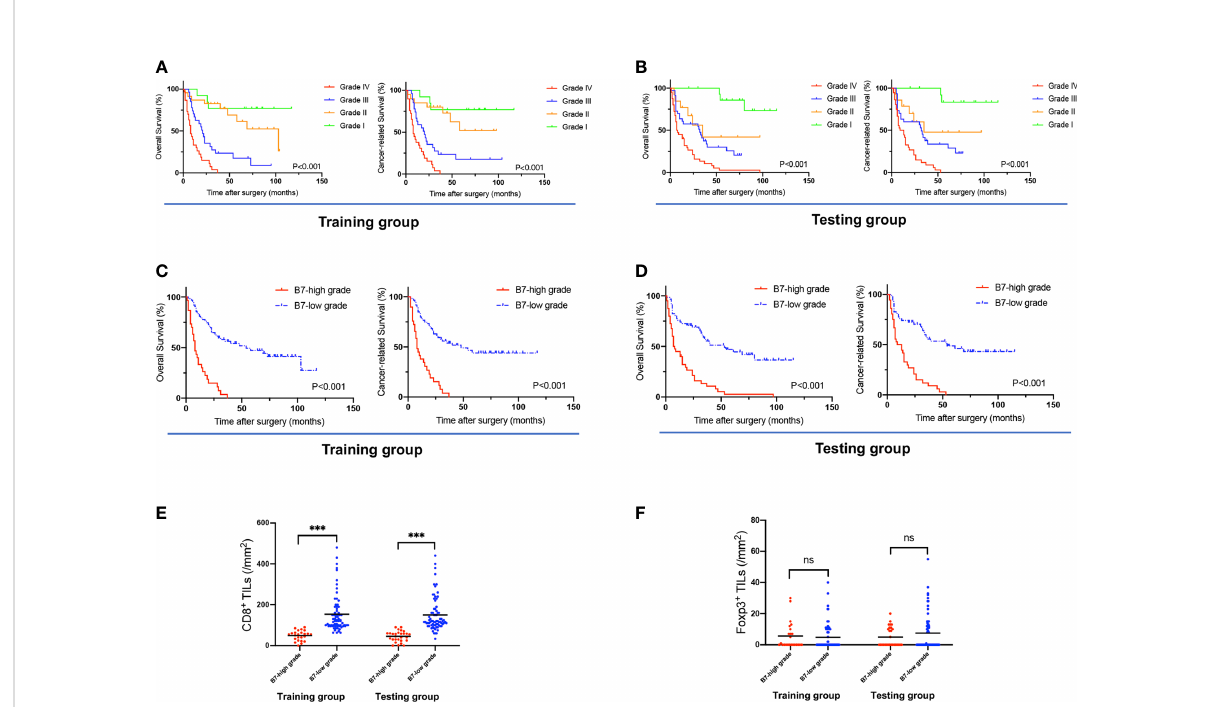
FIGURE 4 The association of B7 strati fi cation with OS, CRS, and TILs. (A, B) Survival curves of OS and CRS, based on B7 strati fi cation, in the training and testing groups. (C, D) Survival curves of OS and CRS based on B7-high grade (grade IV of B7 strati fi cation) and B7-low grade (grades I, II, and III of B7 strati fi cation). (E) The density of CD8+ TILs in tumors associated with B7 strati fi cation (B7-high/low grade) in the training and testing groups. (F) The density of Foxp3+ TILs in tumors associated with B7 strati fi cation (B7-high/low grade) in the training and testing groups. (Error bars indicate the mean, ***p ≤ 0.001, ns, no signi fi